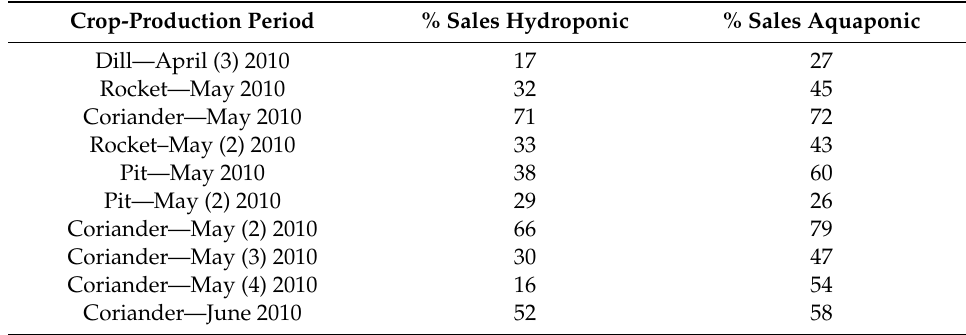
Table 8. Hydroponic vs. aquaponic NFT herb subjective quality